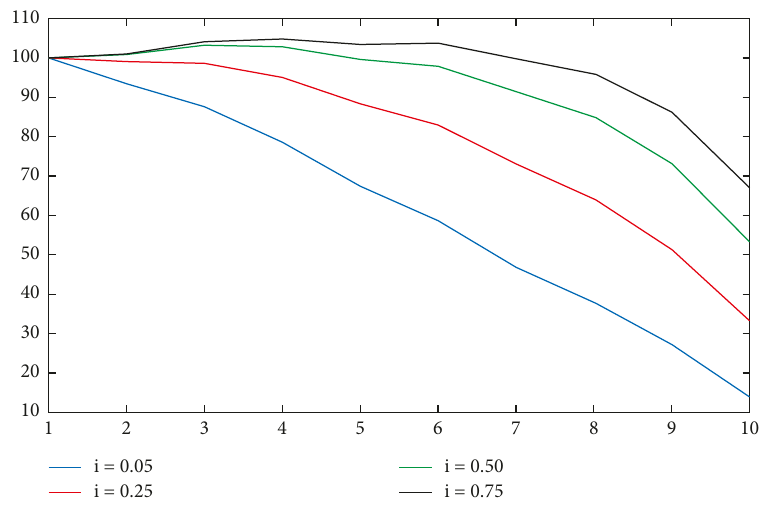
Figure 7: Wealth evolution by varying interest rate. Table 5: Execution time when the initial capital is $ 1